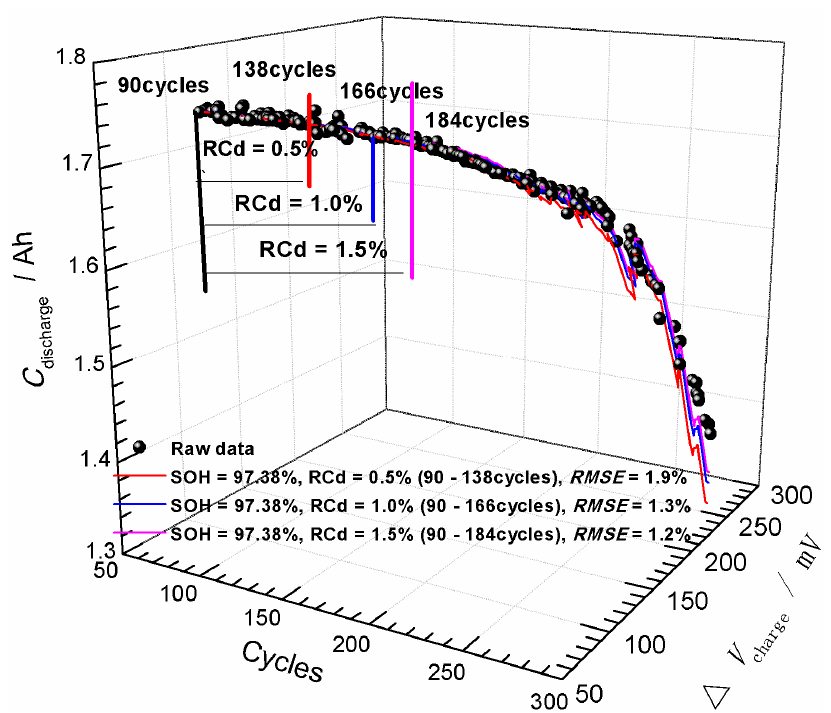
Figure 4. 3D diagram of ( C discharge - Δ V charge - n ) for a Ni-MH battery in the charge-discharge test at 1.0C and the prediction curves obtained with SOH = 97.38% and different relative capacity drops (RCds) (0.5%, 1.0%, and 1.5%).